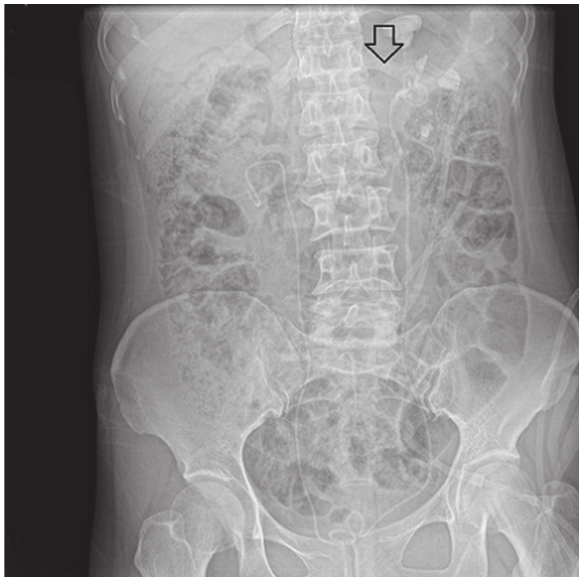
figure 2 - The radiograph of the kidneys, ureters and bladder revealing the tip of nephrostomy tube (white arrow) lodged at the site of entry into the renal vein. Additional findings including another nephrostomy tube and a double-J stent.